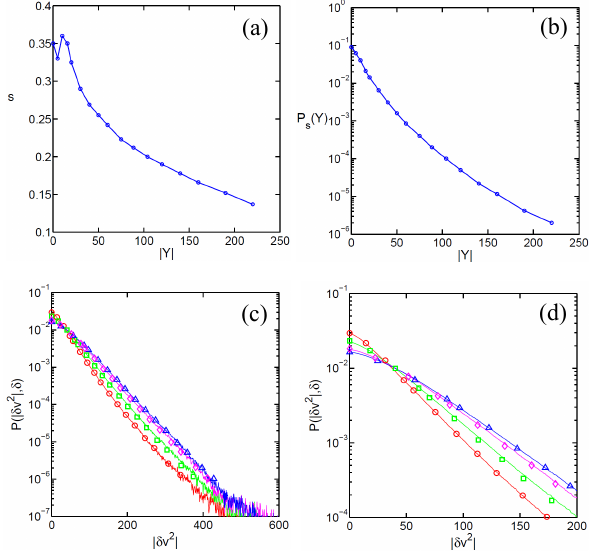
Fig. 10. Fluctuations of v 2 . (a) and (b) : ROMA spectrum s(Y ) and scaled PDF P s (Y) . (c) and (d) : plots of P( | δv 2 | ,δ) : solid curves are from JHU data and markers are from ROMA scaling relations: red (circles) for δ = 24 1 ; green (squares) for δ = 48 1 ; magenta (diamonds) for δ = 96 1 ; blue (triangles) for δ = 128 1 . (d) is an enlarged plot for | δv 2 |≤